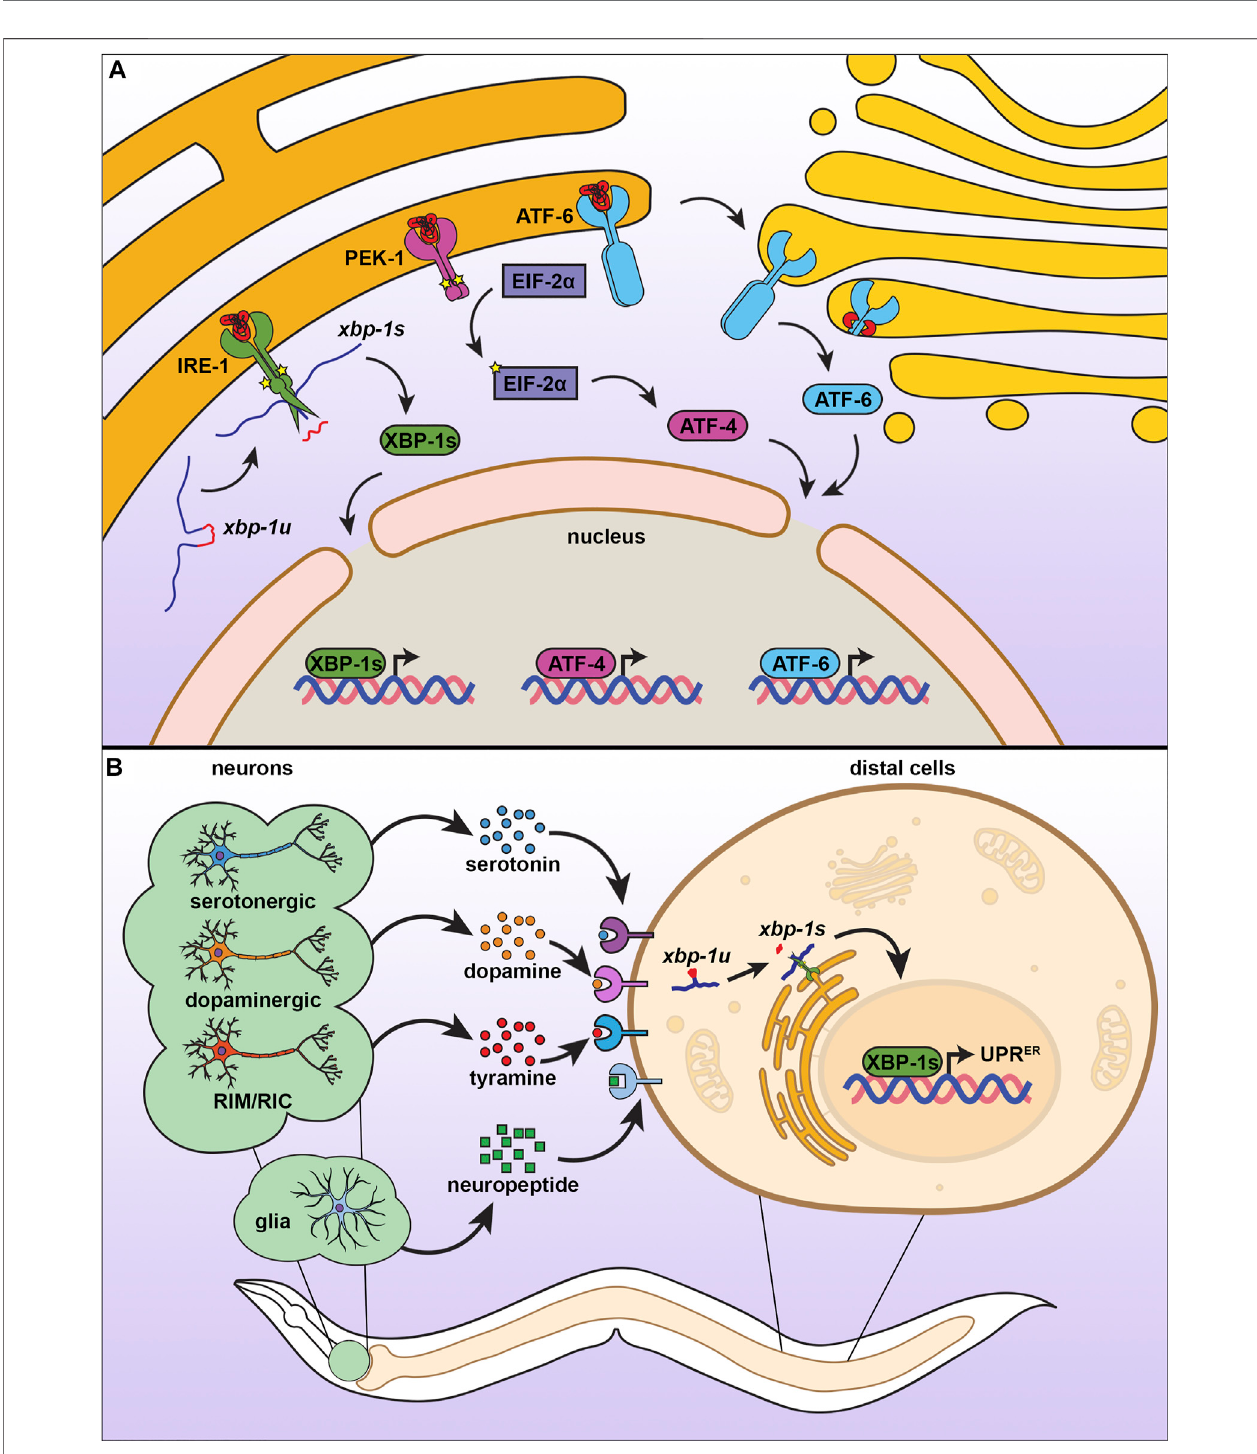
FIGURE 3 | The endoplasmic reticulum unfolded protein response. (A) There are three branches of UPR ER , each consisting of an ER transmembrane protein with different mechanisms of action. When IRE-1 senses misfolded proteins, it homodimerizes, autophosphorylates, and promotes splicing of xbp-1u to xbp-1s , which can thenbetranslatedintothetranscriptionfactorXBP-1s,whichactivatesUPR ER .SimilartoIRE-1,PEK-1undergoesoligomerization,whichinduceseIF2 α phosphorylation and activation of ATF4 to inhibit global translation. ATF6 is activated by proteolytic cleavage under ER stress, which causes translocation to the Golgi for further processing, resulting in a transcriptionally active ATF6 that promotes UPR ER . (B) The UPR ER is communicated in a nonautonomous manner through multiple neuronal subtypes and through glial cells. Serotonergic, dopaminergic, and RIM/RIC neurons signal to peripheral cells using speci fi c neurotransmitters, whereas glial cells communicatethroughneuropeptidesignaling.Whilethe exactidentify ofreceptors involvedhavenot yetbeen fullycharacterized,distal cellsrespond bypromoting IRE- 1-dependent splicing of xbp-1s to induce the UPR ER .